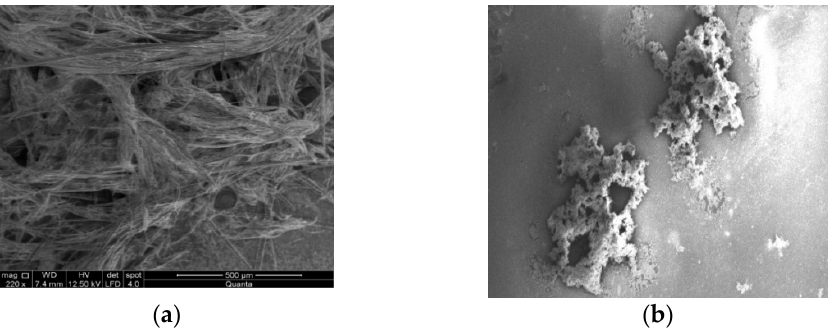
Figure 4. ( a ) SEM images for G1 xerogels dried from dichloromethane. ( b ) SEM images for compound G3 .